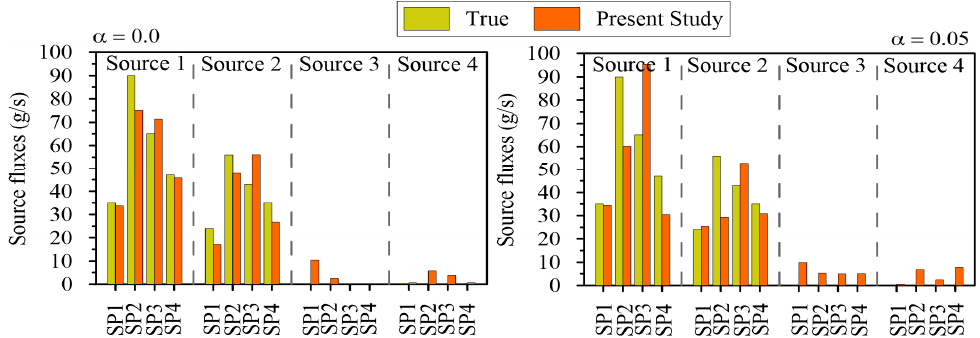
Figure 10. General transfer function curves in seven sampling wells due to source 3 ( a ) and source 4 ( b ); they represent g ( x , t ) of Equation (5). Water 2020 , 12 , x FOR PEER REVIEW